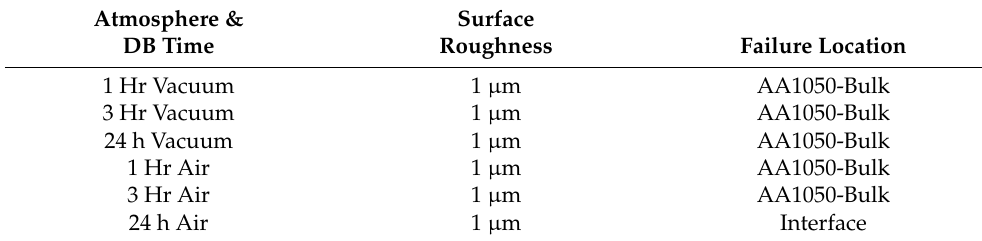
Figure 11. The two types of failure modes observed in the tensile tests: Ductile failure of the AA1050 region ( a1 – a4 ) and brittle failure of the bonded interface ( b1 – b4 ). These modes appear consistently in 5 repetitions of the test ( a4 and b4 ). Table 6. Failure location of the tensile specimens for the first set of